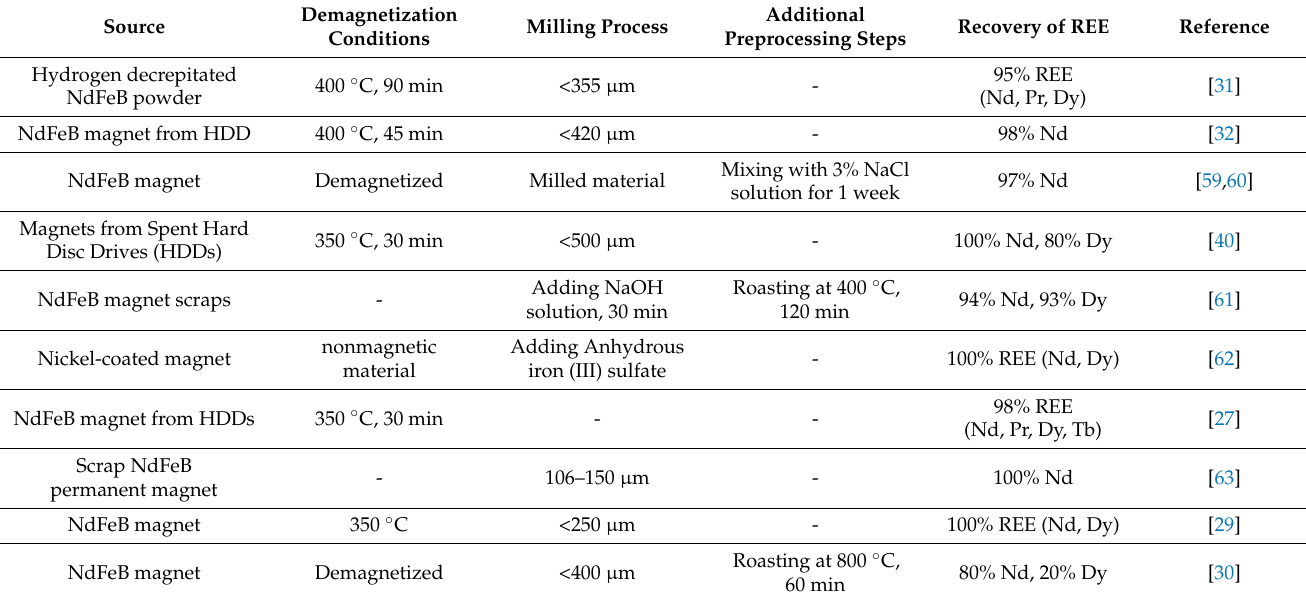
Table 4. Proposed preprocessing methods of NdFeB permanent